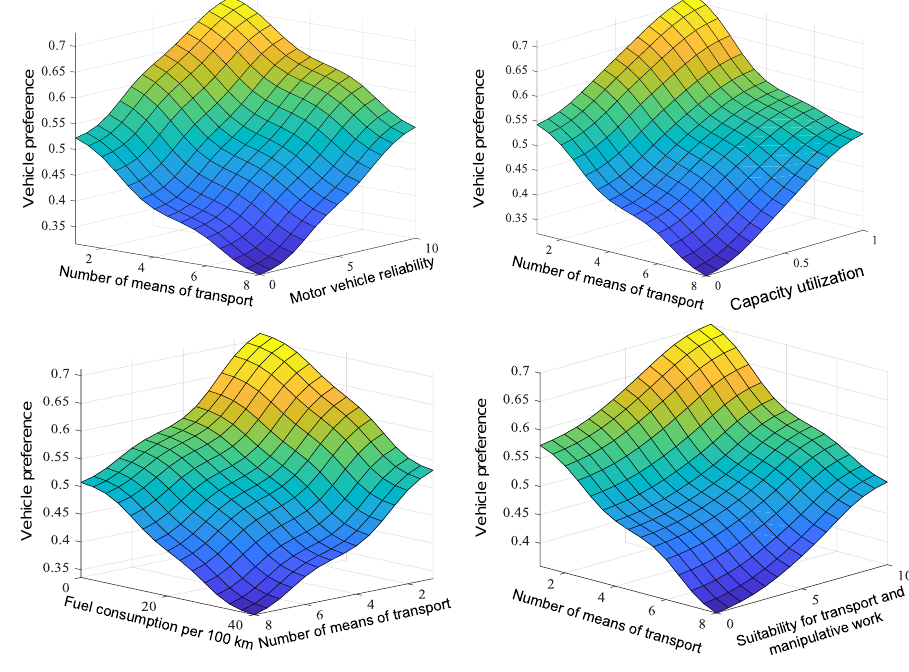
Figure 7 – Interdependence of the solution and two input variables by the PROD-SUM